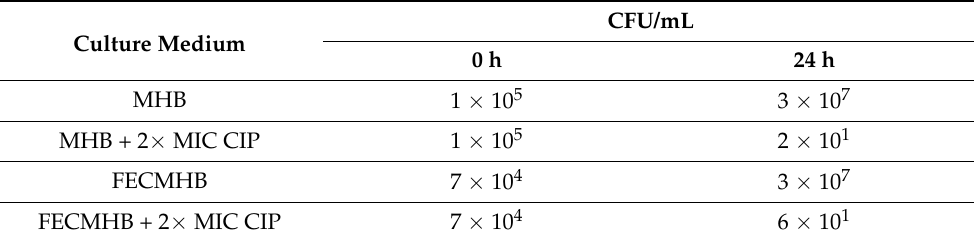
Table 3. Colony counts of ciprofloxacin-treated Staphylococcus aureus ATCC 25923 in replete and